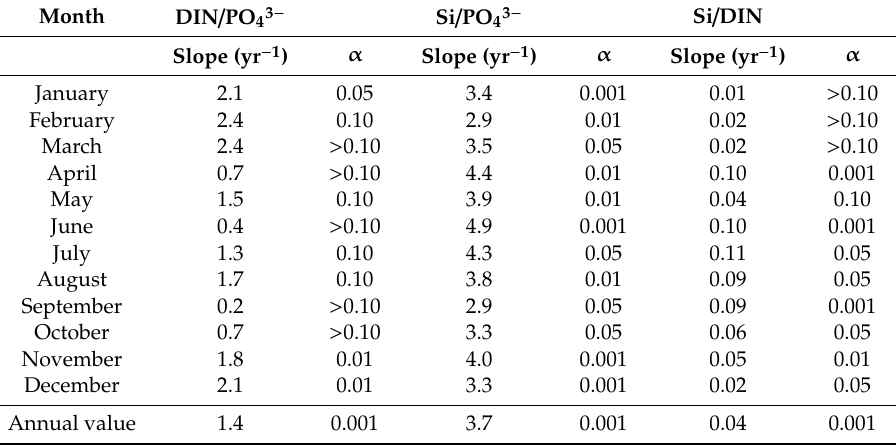
Figure 8. Time series of depth-integrated concentrations ( µ mol L − 1 ) of PO 43 − ( A ), DIN ( B ) and Si(OH) 4 ( C ) at the station C1 (median, quartiles and range) in comparison to the largest hypoxia (H) and anoxia ( A ) events recorded in the GoT. Gray and white areas indicate the major phases of phytoplankton dynamics shown in the Section 3.1. Table 3. Monthly (annual) trends (yr − 1 ) of the ratios of depth-integrated nutrient concentrations ( µ mol L − 1 ) at the station C1 in 1992–2018, calculated with MK and S